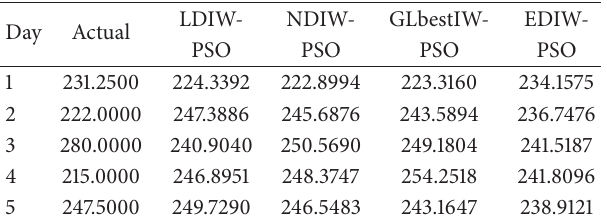
Table 4: The results of predicted ouput by four models for the daily air quality index (AQI) of Xi’an of the following five days (2014.2.6– 2014.2.10).